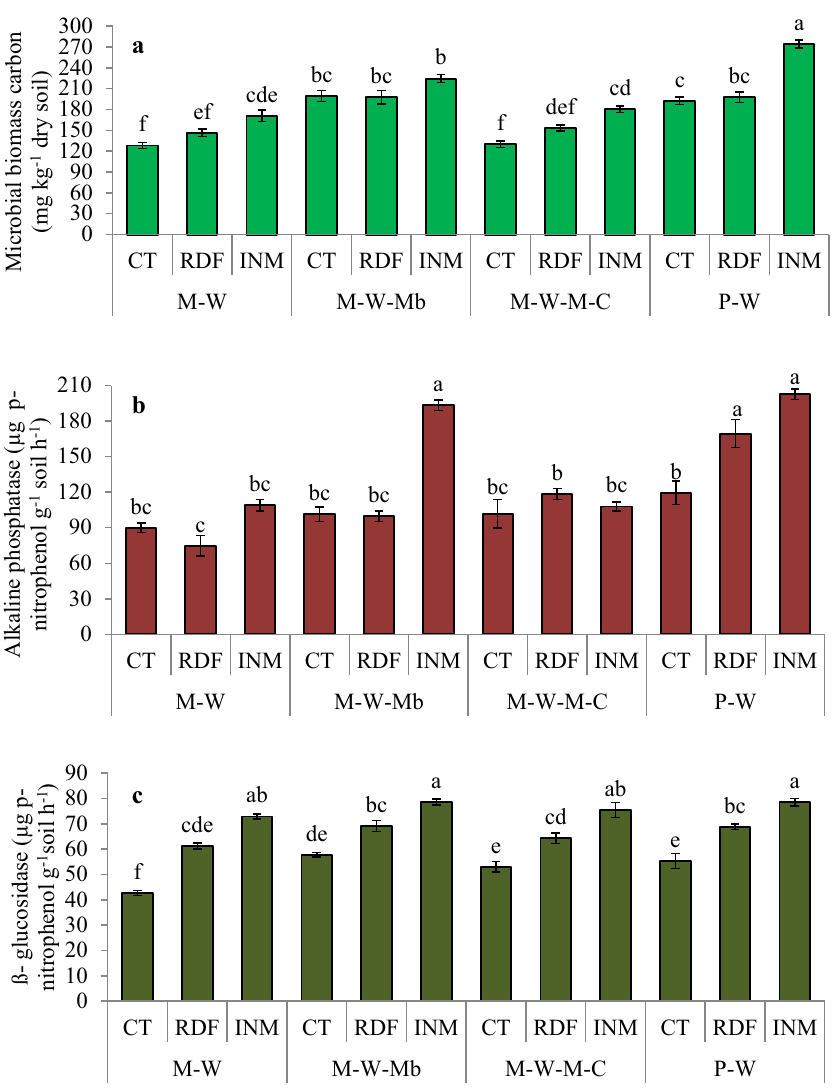
Figure 2. Impact of management practices on soil biological properties; lowercase letters (a–f) delineates significant difference at p ≤ 0.05 using Tukey’s honest significance